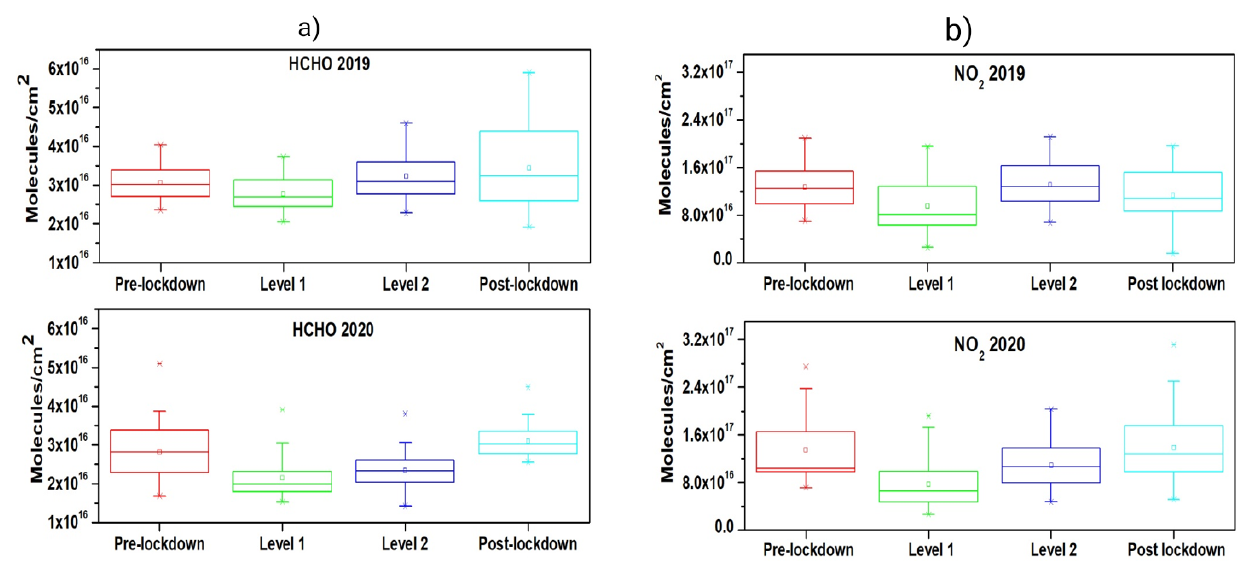
Figure 6. The boxplot categorized into four levels of the study period for ( a ) formaldehyde (HCHO) and ( b ) nitrogen dioxide (NO 2 ) vertical column densities (VCDs) attained from the MAX-DOAS instrument.